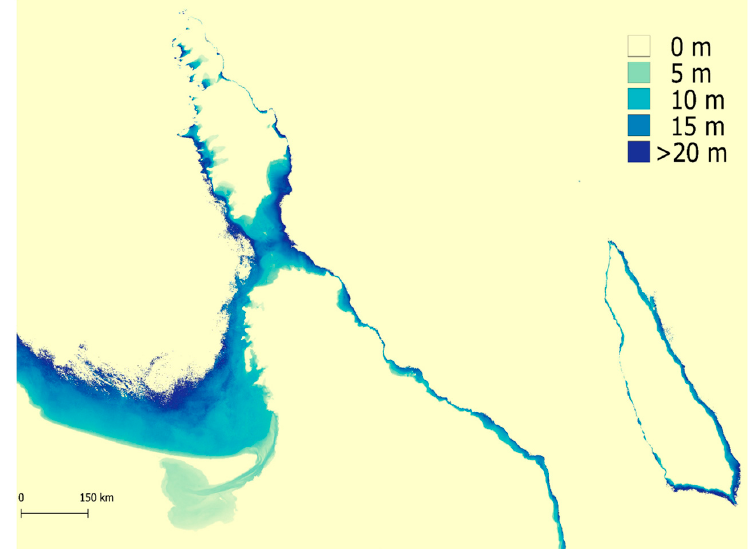
Figure 9. 4SM is capable of calculating bathymetry values without field data and this is the results of satellite derived bathymetry for the whole La Paz bay.